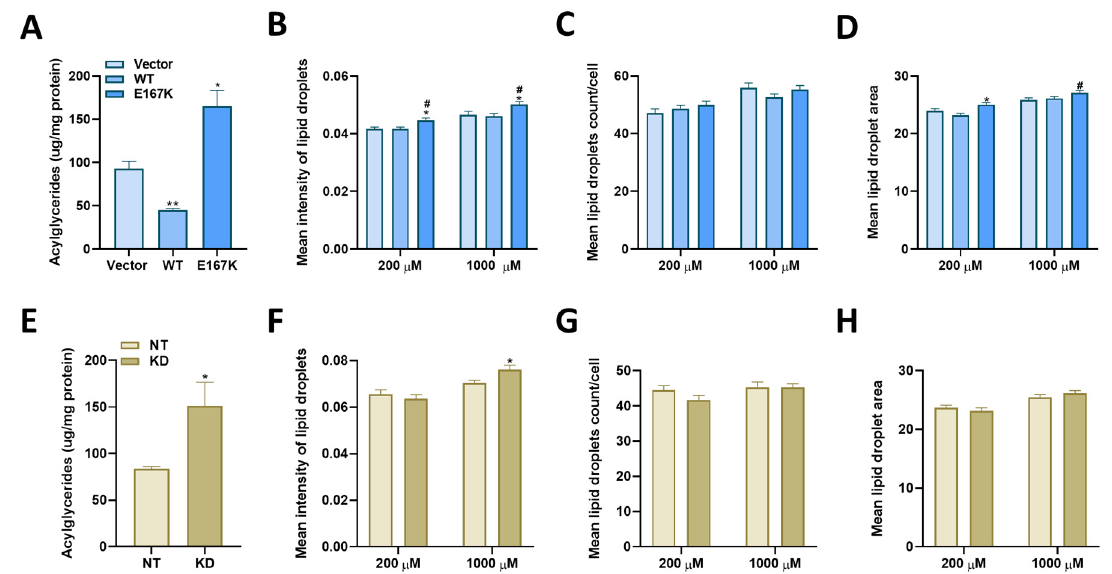
Figure 1. Effects of TM6SF2 on intracellular lipid accumulation and lipid droplet profile in oleic acid treated Huh-7 cells. ( A , E ) Biochemical measurement of intracellular acylglyceride concentrations (TG, DG, MG) in Huh-7 cell lines treated with 200 µ M oleic acid for 24 h. Quantitation of ( B , F ) mean intensity of lipid droplets, ( C , G ) number of lipid droplets per cell and ( D , H ) mean area of lipid droplets in Huh-7 cell lines treated by 200 µ M or 1000 µ M oleic acid for 24 h and stained with Hoechst (nuclei) and LipidTox Green (neutral lipids). Data presented as mean + S.E.M. from 3 independent experiments, * significantly different than control cells (Vector or NT), * p < 0.05, ** p < 0.01, # significantly different than wild-type TM6SF2 overexpression cells (WT), # p < 0.05. p -values for ( A , E ) were calculated using the Student’s T-test. p -values for all other comparisons were calculated by using the Wilcoxon Rank Sum Test. Wild-type TM6SF2 (WT), E167K mutant variant TM6SF2 (E167K), pCMV empty vector control (Vector), non-targeted shRNA control (NT), and TM6SF2 knockdown (KD).